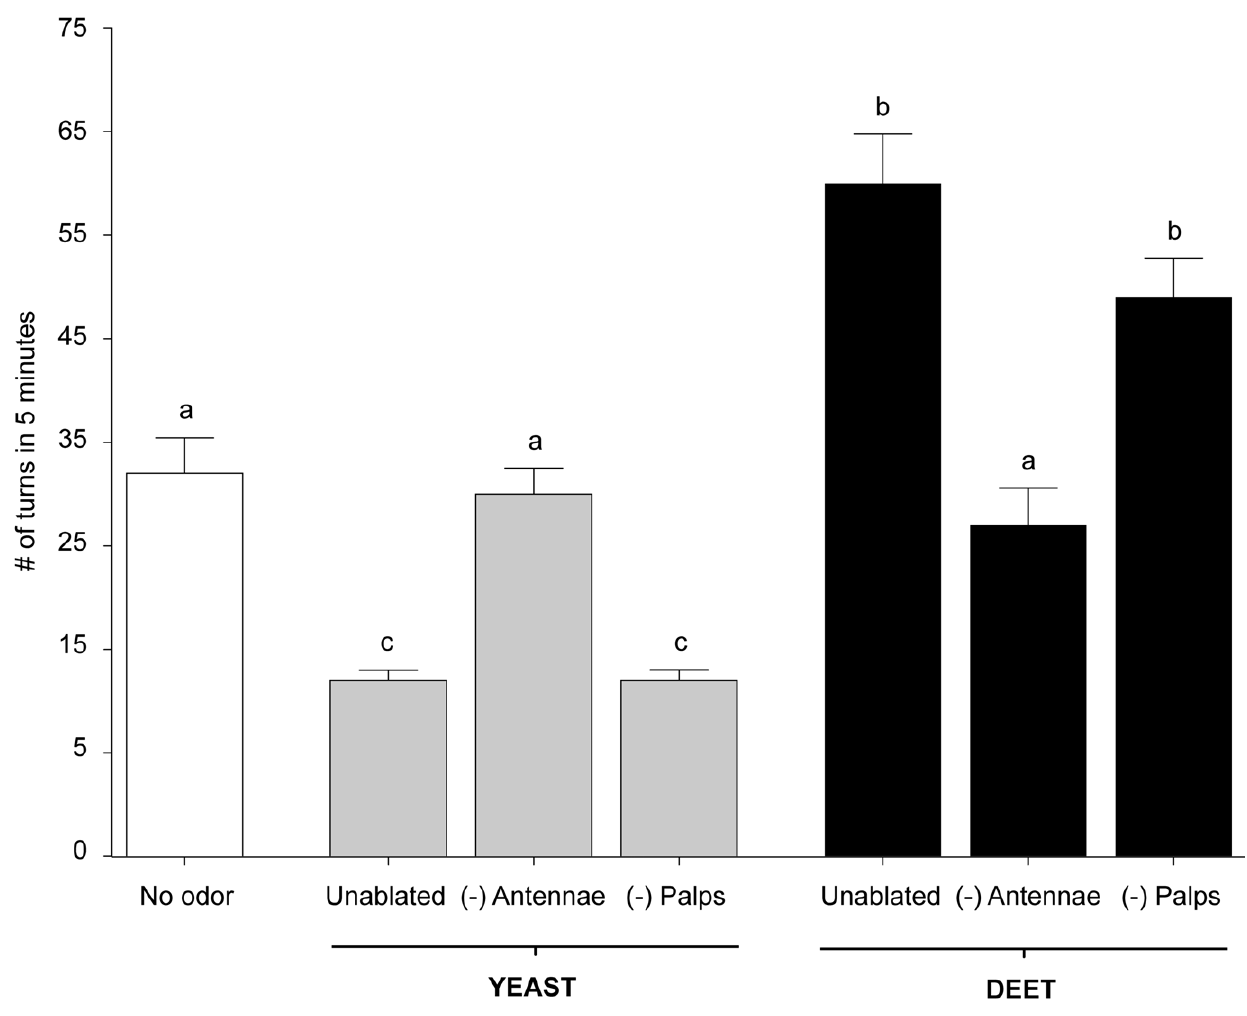
Figure 4. Larval antennae mediate responses to yeast and DEET. In the presence of yeast and DEET, unablated and palp-ablated larvae responded equally to both; ablation of the antennae, however, significantly increased or decreased the number of turns ( p , 0.05) in response to yeast and DEET, respectively. Results are shown as means 6 SE, n =10.